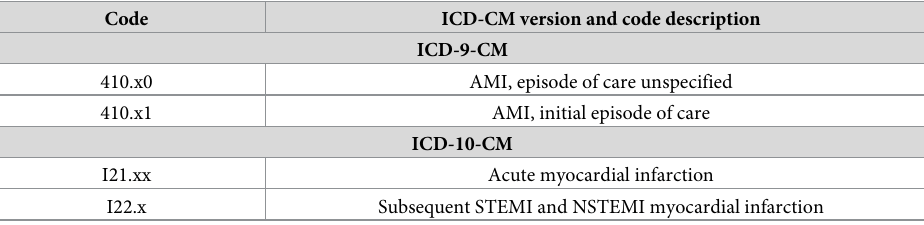
Table 1. ICD-CM codes selected for identification of AMI �